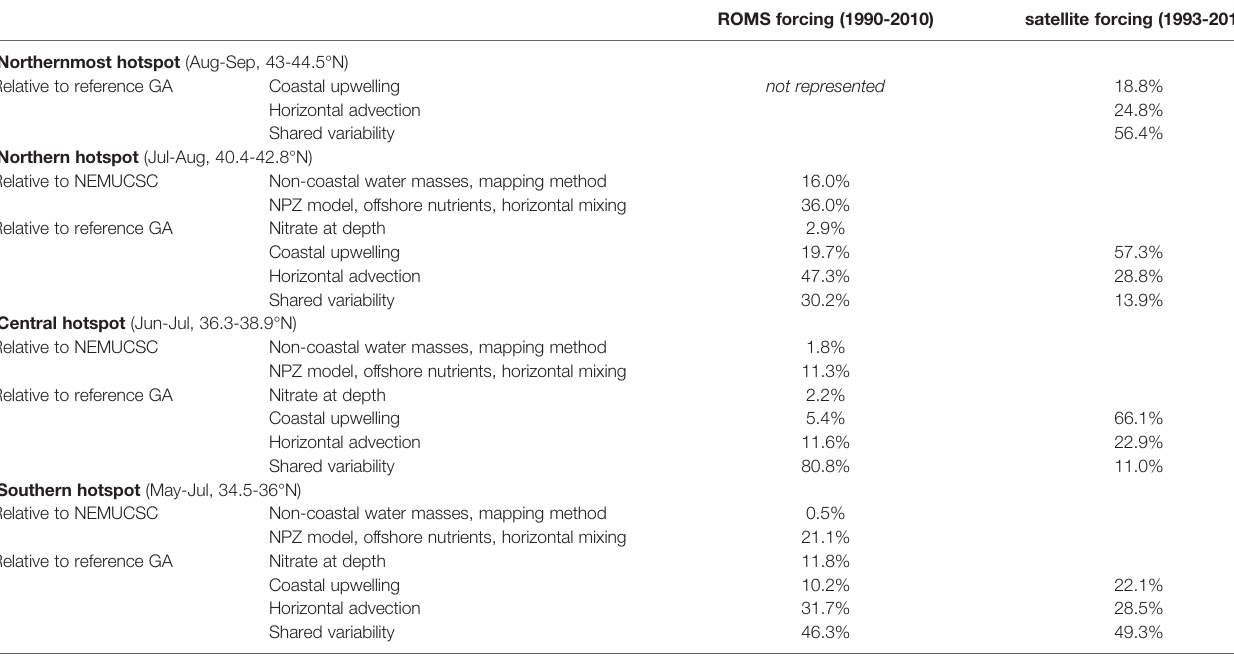
TABLE 2 | Percentage of variance explained by various processes for each yearly hotspot time series.